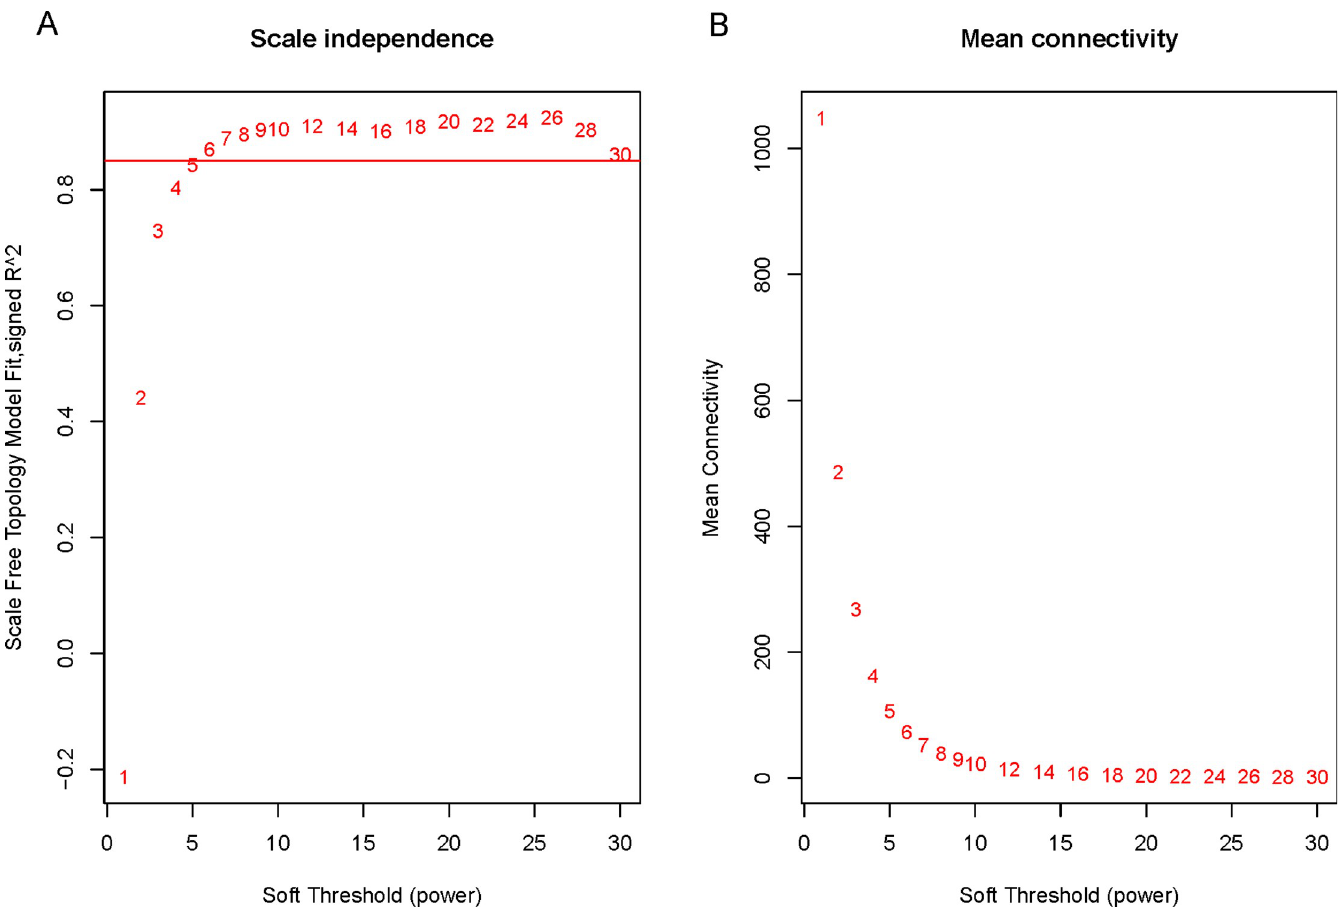
Fig 1. The relationships of Soft Threshold (power) with network properties (scale independence and mean connectivity). (A) Scale Free Topology with the change of power. (B) Mean Connectivity of the network with the change of power. When the power was set to 6, the scale-free topology can exceed 0.85 and the connection was stable. Therefore, we used power = 6 to construct the WGCNA